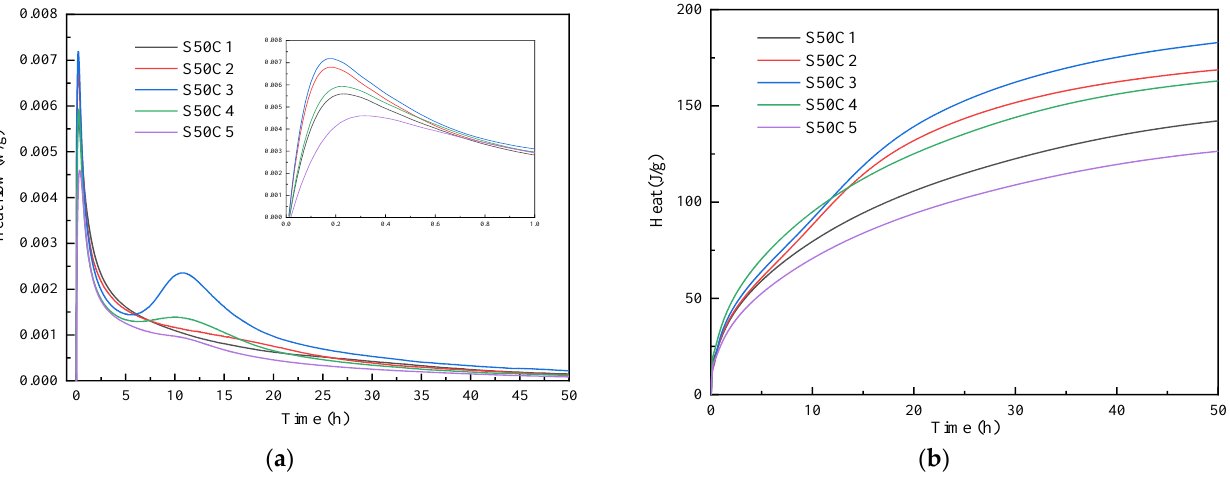
Figure 4. Comparison of the reaction heats of alkali-activated composite cementitious materials under different activator concentrations: ( a ) exothermic reaction rate; ( b ) total heat release.